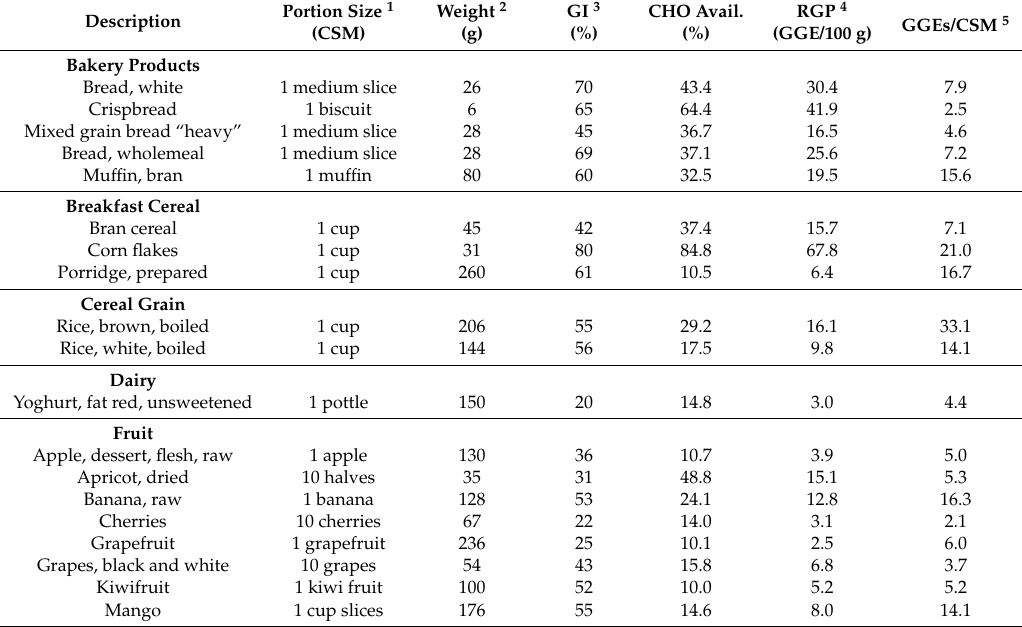
Table 1. Estimation of relative glycaemic potency (RGP) of foods as glycaemic load for a selection